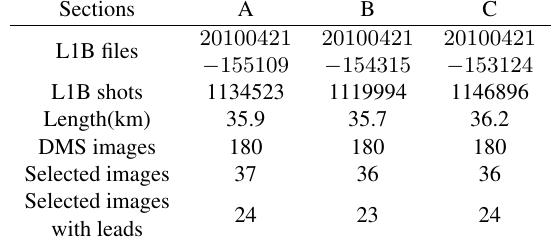
Table 1. Some information about selected three sections of ATM L1B files and the DMS images